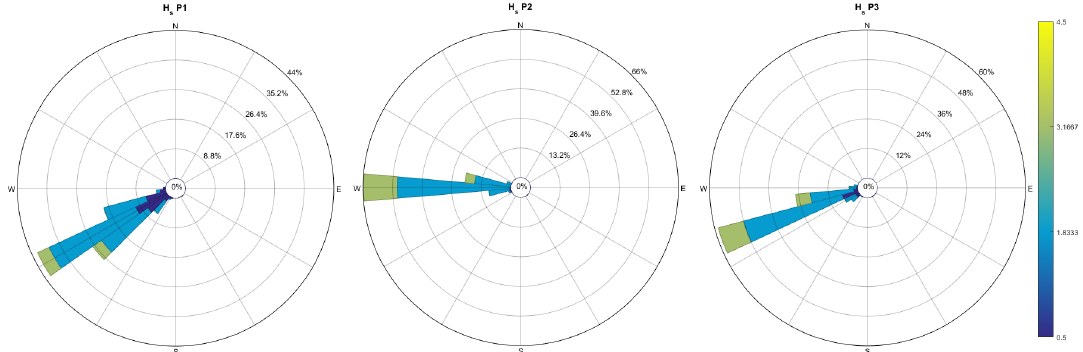
Figure 10. Polar diagrams of early significant wave height for the prospective locations in Penyu Bay coast where P1 to P3 represent pin locations number 1 to number 3.